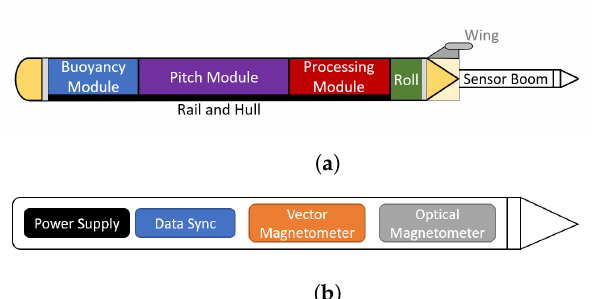
Figure 2. Block diagram of ROUGHIE showing control modules utilized for vehicle control ( a ). Aft of the vehicles stern is the sensor boom, comprising all of the magnetic sensing equipment ( b